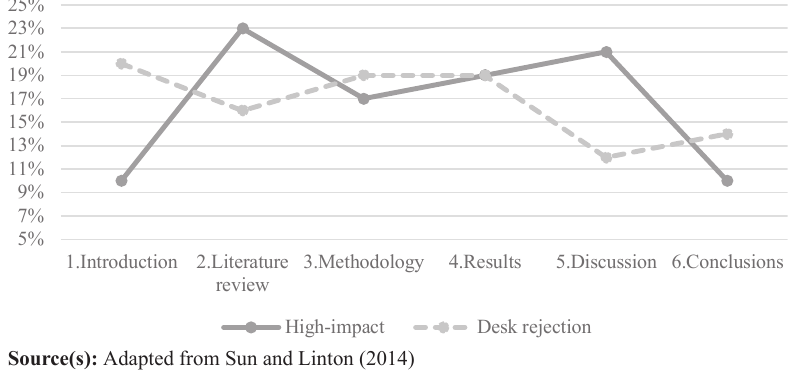
Figure 3. Average structure